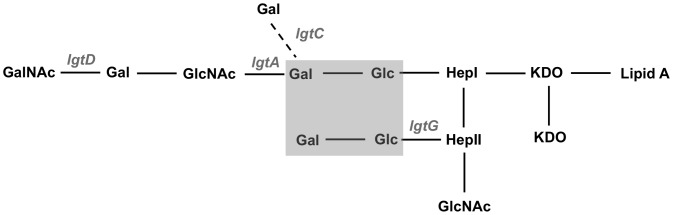
Simplified schematic of the oligosaccharide (OS) structure of gonococcal LOS.Lipooligosaccharide glycosyl transferase (lgt) genes that are involved in LOS biosynthesis and are subject to phase variation are indicated in grey italic font. Each transferase catalyzes the substitution of the next more distal hexose onto the LOS backbone. The grey shaded box represents the minimum OS structure expressed by naturally occurring gonococcal strains that is required for mAb 2C7 binding.